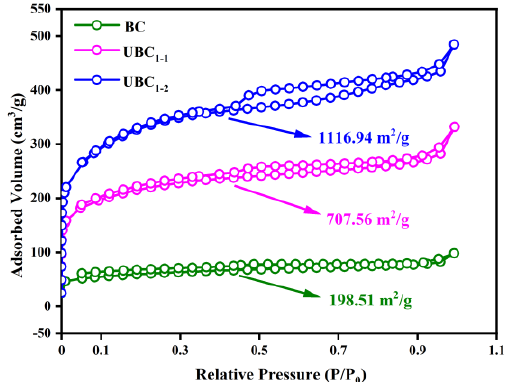
Figure 1. The N 2 adsorption − desorption isotherms of BC, UBC 1 − 1 , and UBC 1 − 2 . Table 1. Physicochemical characteristics of